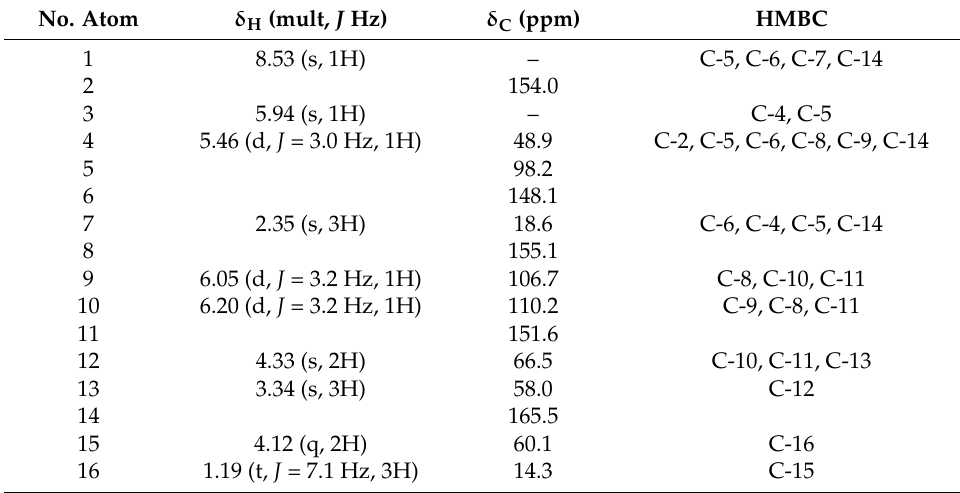
Table 1. NMR data of Ethyl 4-[5-(methoxymethyl)furan-2-yl]-6-methyl-2-oxo-1,2,3,4-tetrahydropyrimidine- 5-carboxylate in CDCl 3